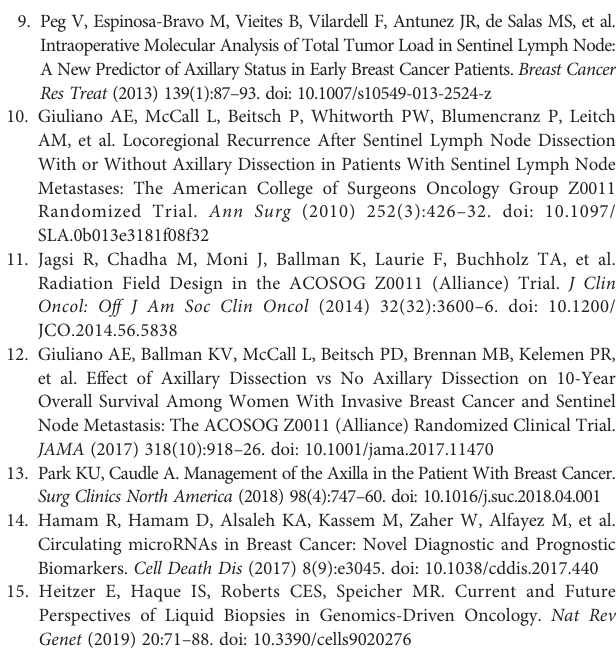
added to the samples prior to RNA isolation. We observed an excellent correlation of counts corresponding to the spike-ins between the samples. Supplementary Figure 2 | Summary of the mapping results for the samples. (A) Total number of reads for each sample sequenced. (B) Read length distribution for each class of RNAs. The peak around 18-23 nucleotides (red) corresponds to miRNAs. Supplementary Figure 3 | RNA-sequencing validation. Relative gene expression was performed according to the comparative ddCt ( DD Ct) method using negative metastatic samples as reference. The geNorm or the Norm fi nder algorithm were used to select the best combination of two reference genes. Data from multiples plates were normalized using UniSp3 spike-in as interplate calibrators. Each microRNA was assayed twice by qPCR on the Serum/plasma Focus microRNA PCR panel. (A) Data shows the comparison between patients with negative and positive SLNs. (B) Patients with positive SLNs were divided according to the presence or absence offurther axillary lymph nodes (aLNs). Statistical analysis was performed using unpaired Student ’ s t-test. All comparisons shown are statistically signi fi cant (p < 0.05). Supplementary Table 1 | Mapping and yield results of the sequencing data. Reads are classi fi ed into the following classes: miRNA, maps to mirBase_20; small RNA, maps to sRNA database compiled by Exiqon; Predicted miRNA, predicted miRNAs using a prediction software; Genome, reads aligning to the referencegenome,butnottomiRNAsorsRNAs;Outmapped,mapscorresponding to poly A and poly homopolymers as well as abundant rRNA and mtRNA; Unmapped, reads not aligning to reference genome. Median values for each type of reads are shown. Supplementary Table 2 | Predicted miRNA results of the sequencing data. Predicted miRNAs for each sample sorted by total read count. The sequences reported do not match any known miRNA in the miRBase_20. The location is formatted as "chromosome: start-stop (strand)". Counts describes the number of reads which fall onto the location of the predicted miRNA (sum of all samples). Note that the name and numbering assigned here are project-speci fi c and cannot be compared with the nomenclature found in the miRBase or other